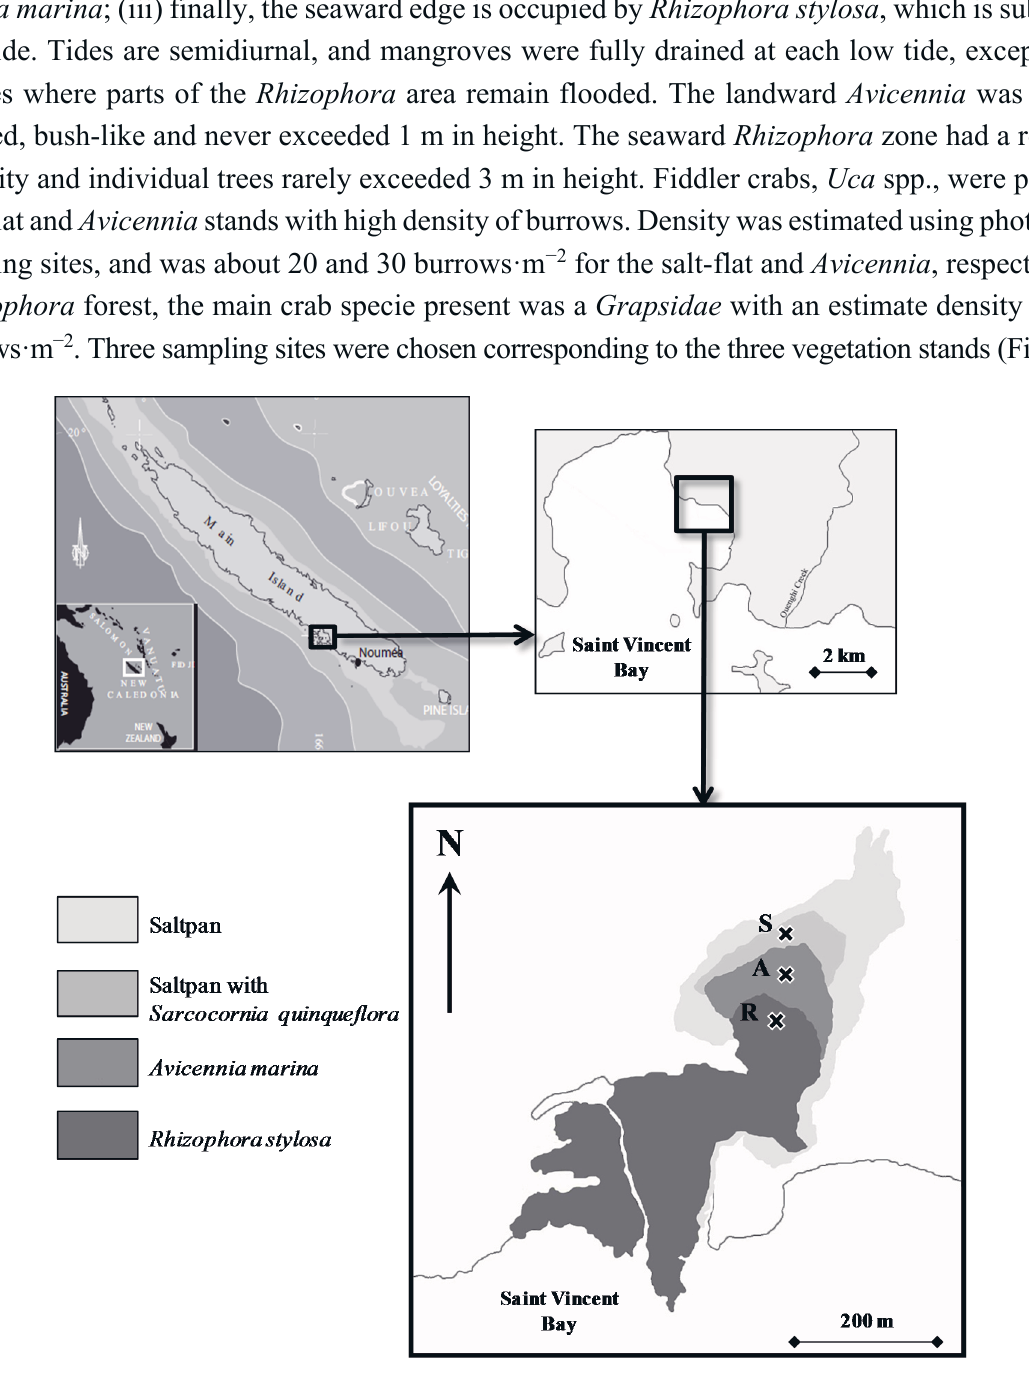
Figure 1. Map showing the location of the studied mangrove in Saint Vincent Bay on the west coast of New Caledonia, with vegetation zonation and the location of sampling sites in: (S) Salt-flat with Sarcocornia quinqueflora , (A) Avicennia marina and (R) Rhizophora stylosa